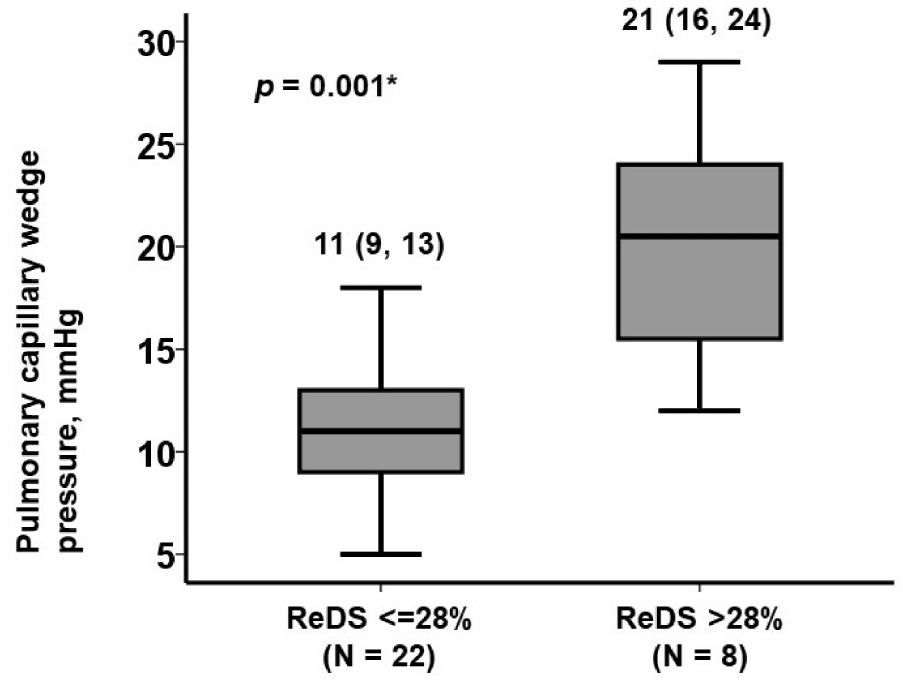
Figure 4. PCWP levels stratified by the cutoff of ReDS 28%. * p < 0.05 by Mann-Whitney U test.